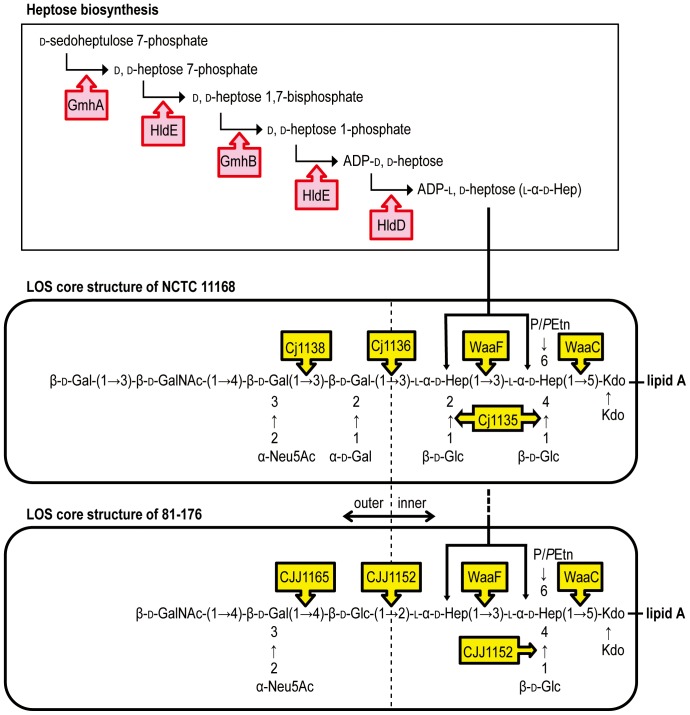
Hypothetical pathways of LOS biosynthesis in C. jejuni NCTC 11168 and 81-176.The enzymes are indicated by arrow boxes. Abbreviations: GalNAc, N-acetylgalactosamine; Neu5Ac, N-acetylneuraminic acid; Gal, galactose; Glc, glucose; Hep, heptose; P/PEtn, phosphate or pyrophosphoethanolamine; Kdo, 2-keto-3-deoxy-d-manno-octulosonic acid.